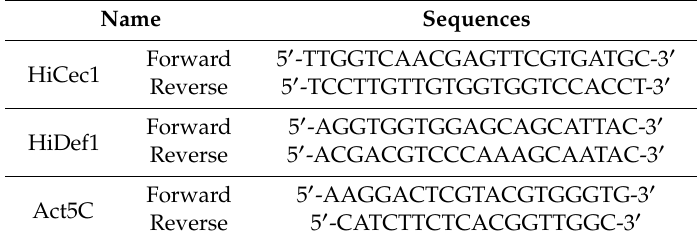
Table 1. Primer sequences used to analyze cecropin 1 and defensin 1 gene expressions by real-time